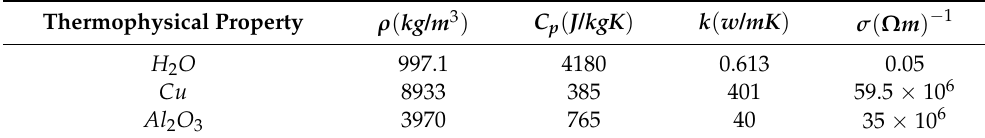
Table 1. Thermophoresis properties of water and nanoparticles [40].